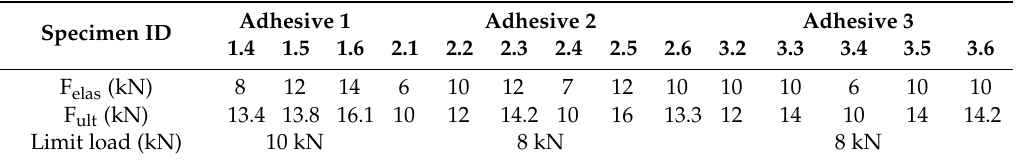
Table 5. Experimental values of the elastic limits and failure loads of the various specimens, and recommended limit